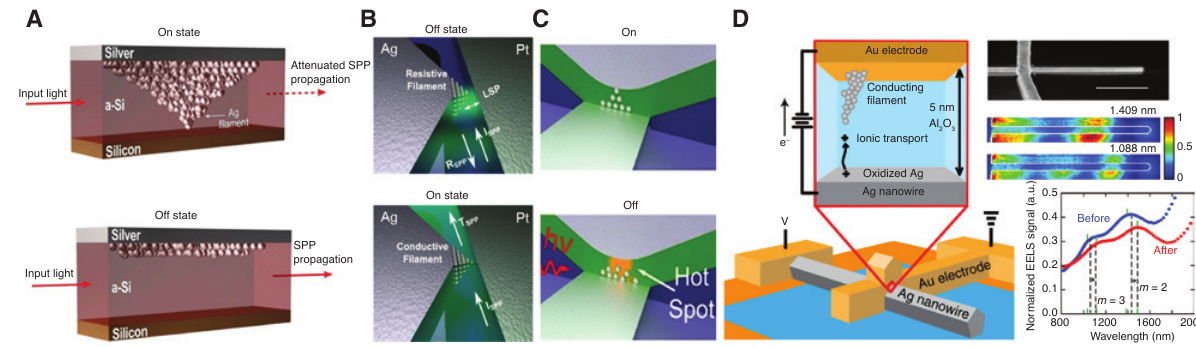
Figure 5: (A) Formation and annihilation of the nanoscale filament with optical readout functionalities, reprinted with permission from Ref. [53], Copyright 2013 American Chemical Society. (B) Interaction of incident light (ISPP) with the resistive (OFF state) and conductive (ON state) filament resulting in transmission (TSPP) and reflection (RSPP) depending on the gap distance LSP. (C) Zoom to the critical switching area. Reprinted with permission from Ref. [54], Copyright 2015 American Chemical Society from https://pubs.acs.org/doi/abs/10.1021%2Facs. nanolett.5b04537 (further permissions related to the material excerpted should be directed to the American Chemical Society). (D) Schematic of a device for probing the electrical and optical switching properties by means of Electron Loss Spectroscopy (EELS). The zoom-in illustrates the proposed switching mechanism. The device shown in the STEM image (scale bar 400 nm) acts as an optical antenna and the switching affects the optical properties as can be seen in the STEM EELS maps and spectra. Reprinted with permission from Ref. [55] Copyright 2018 American Chemical Society, from Ref. [56] Copyright 2016 https://creativecommons.org/licenses/by/4.0/.